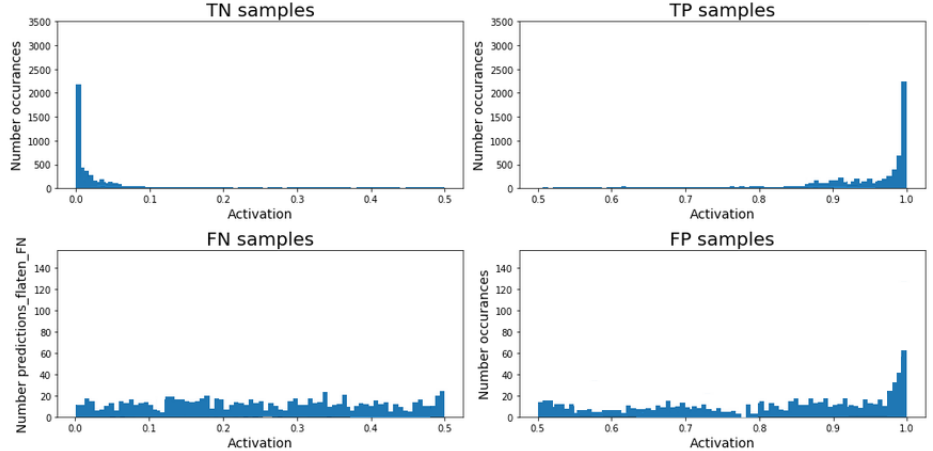
Figure 17. Confidence-level analysis of the CNN-based model for tv D6WH (MUAC region). ( top-left ) TN, ( top-right ) TP, ( bottom-left ) FP, and ( bottom-right ) FN